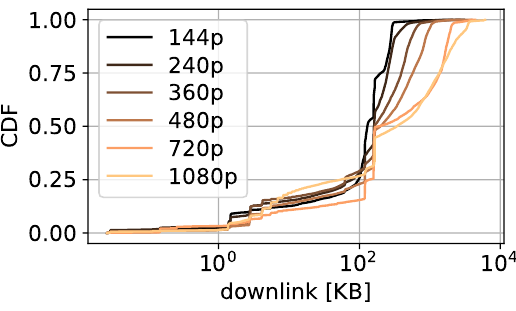
Figure A3. Downlink bytes.